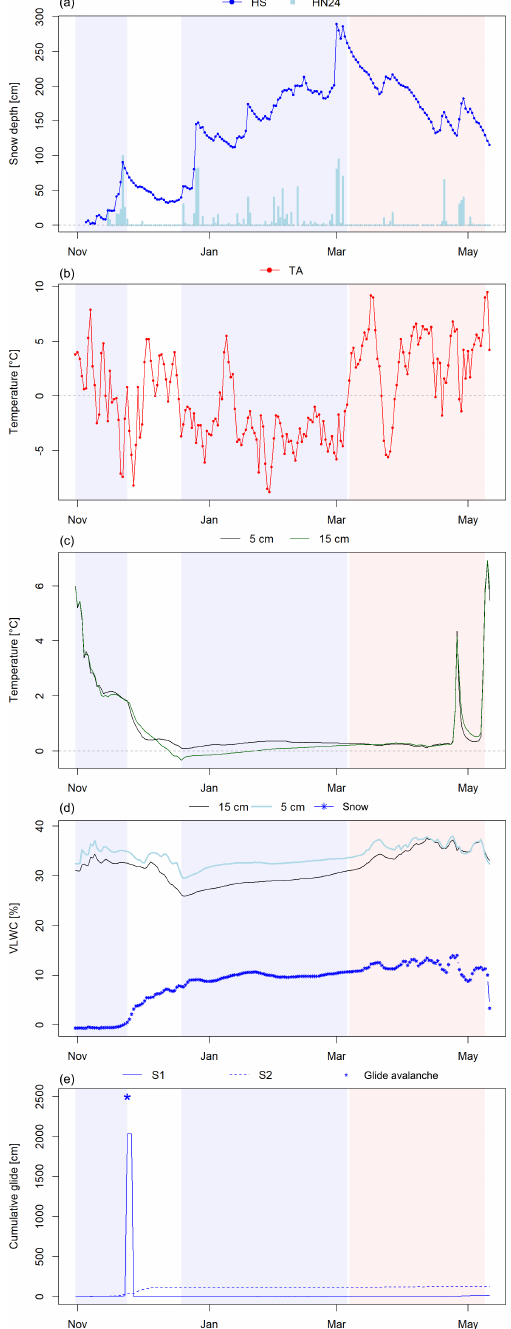
Figure 5. Site Sant’Anna, winter season 2013–2014: (a) snow depth (HS) from AWS Weissmatten and new snow sum (HN24) from manual snow measuring site Gabiet, (b) air temperature (TA) from AWS Weissmatten, (c) soil temperature, (d) VLWC measured within the soil and in the basal snowpack layer, (e) cumulative glide. Warm and cold periods are highlighted in orange and blue, respec- tively; periods reported in white are periods of no data analyses for S1, S2 or both (see Table 1 for